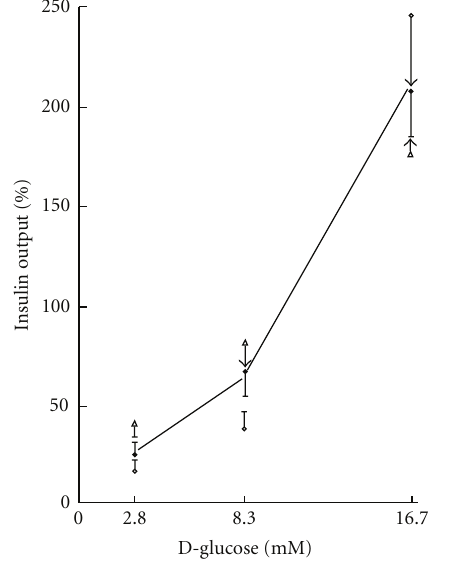
Figure 5: Insulin output by islets from NF control rats (open circles), IF control rats (closed circles), and CR control rats (open triangles) incubated at increasing concentrations of D-glucose. All results are expressed relative to the overall mean values recorded at the three concentrations of the hexose in each type of rats. Mean values ( ± SEM) refer to 10 (NF and CR rats) or 20 (IF rats) separate measurements, the SEM bar ending by an arrow whenever it exceeded the space to the next mean value. The solid line refers to the overall mean value recorded in the three groups of rats at each hexose